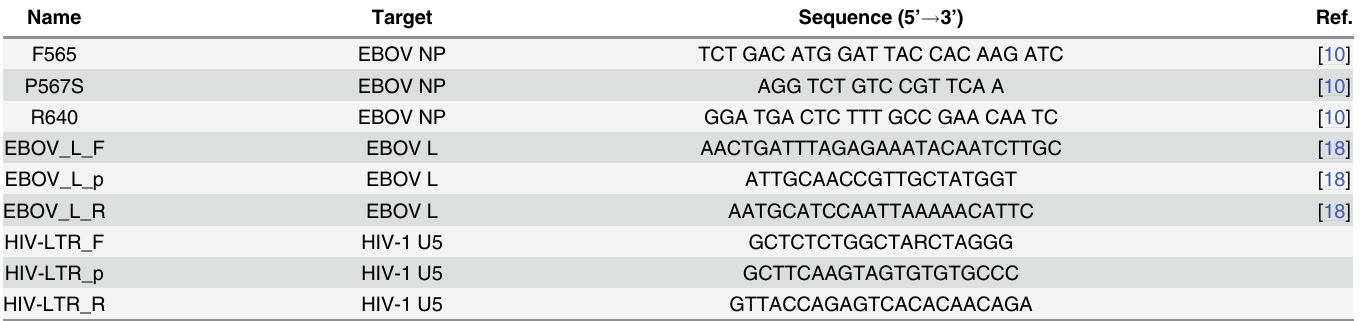
Table 1. Primers and probes